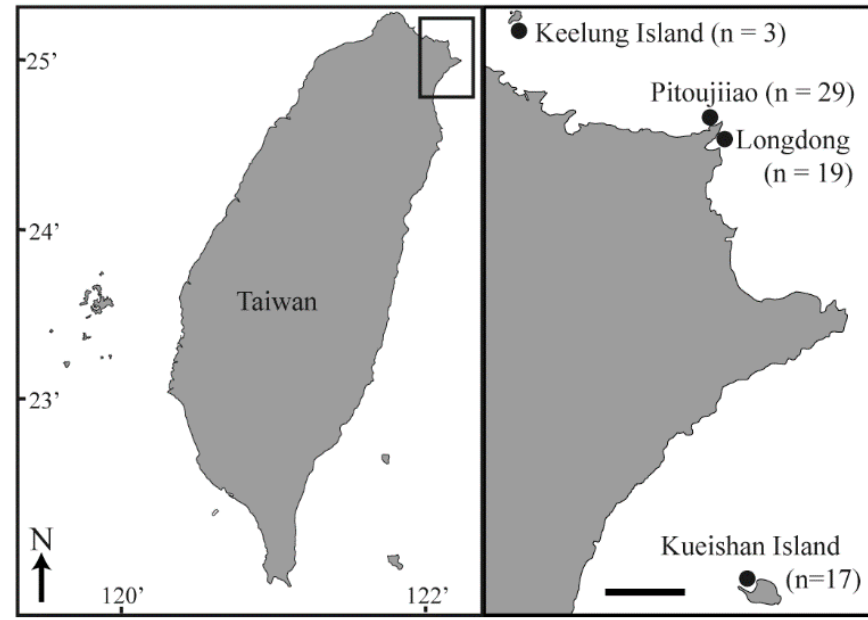
Figure 1. Map showing sampling sites at Pitoujiiao, Longdong, Keelung Island, and Kueishan Island in northeastern Taiwan.